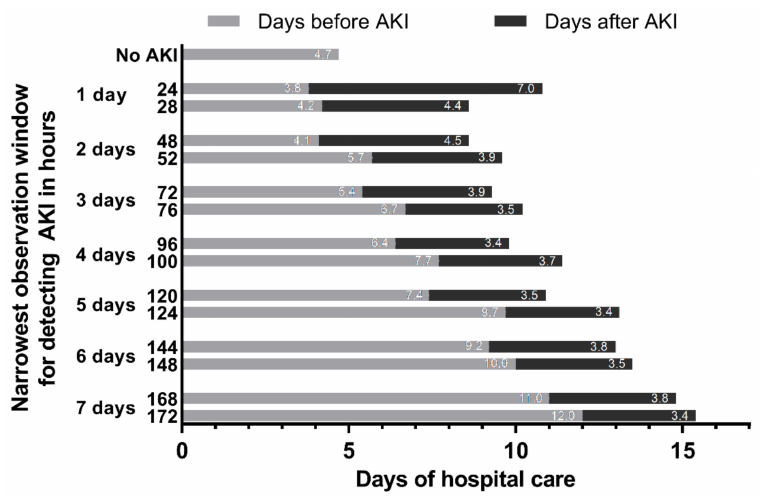
Figure 7. Days of hospital care before and after detection of AKI by narrowest observation win- dow for detecting AKI ( n = 126,367). AKI, acute kidney injury. Days before AKI was calculated as